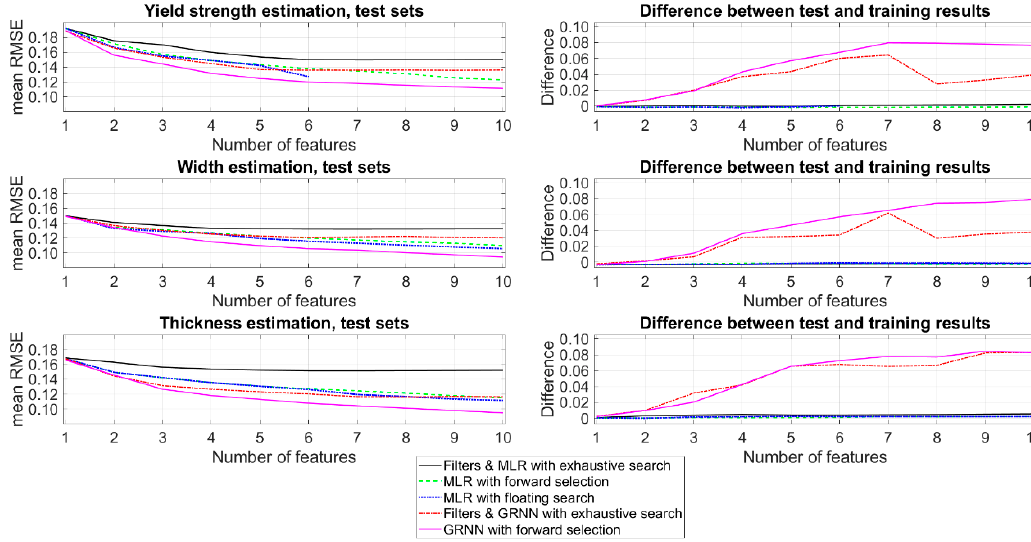
Figure 8. RMSE of the best performing models in feature selection on the left. The difference between test and training results on the right gives indications about overfitting in model training.